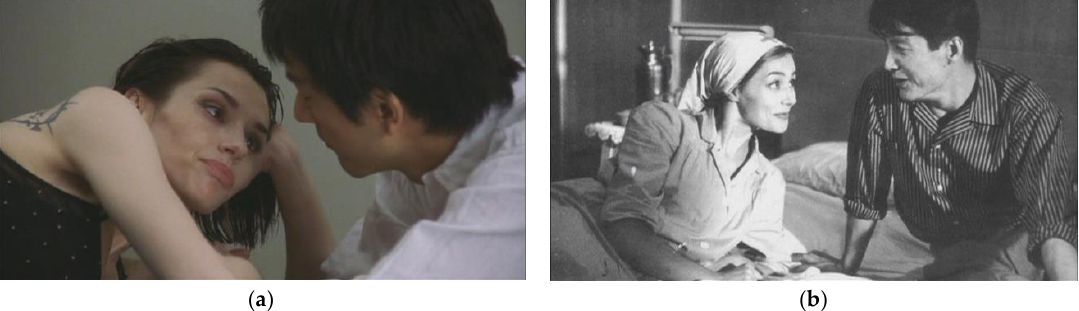
Figure 1. Frame ( a ) from H Story showing actors Béatrice Dalle and Hiroaki Umano representing a scene of Hiroshima mon amour , followed by a frame of the film ( b ) showing a photography of the original scene played by Emmanuelle Riva and Eiji Okada. Source: DVD edition by Cinéma Indépendant (France).